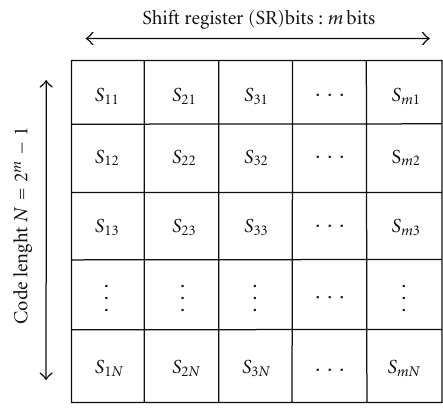
Figure 3: Sample layout of Shift Register